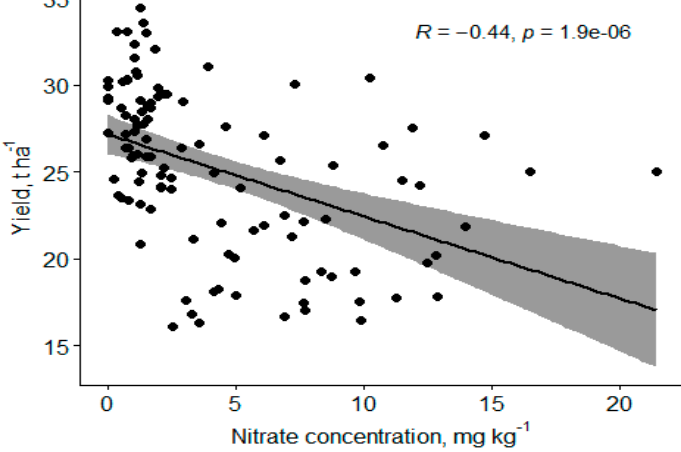
− -N to fruit 3 3 -N to fruit weight.